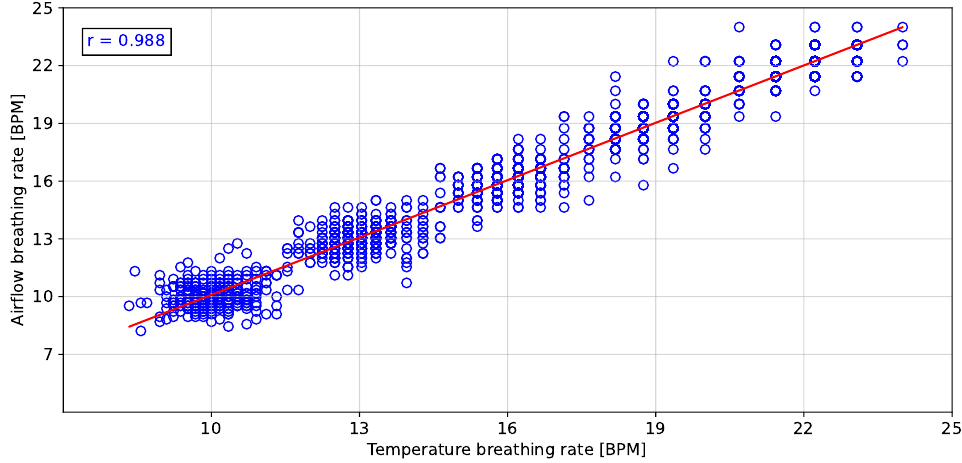
Figure 12. Pearson correlation of the breathing rate from the pressure signal respect to the airflow signal.